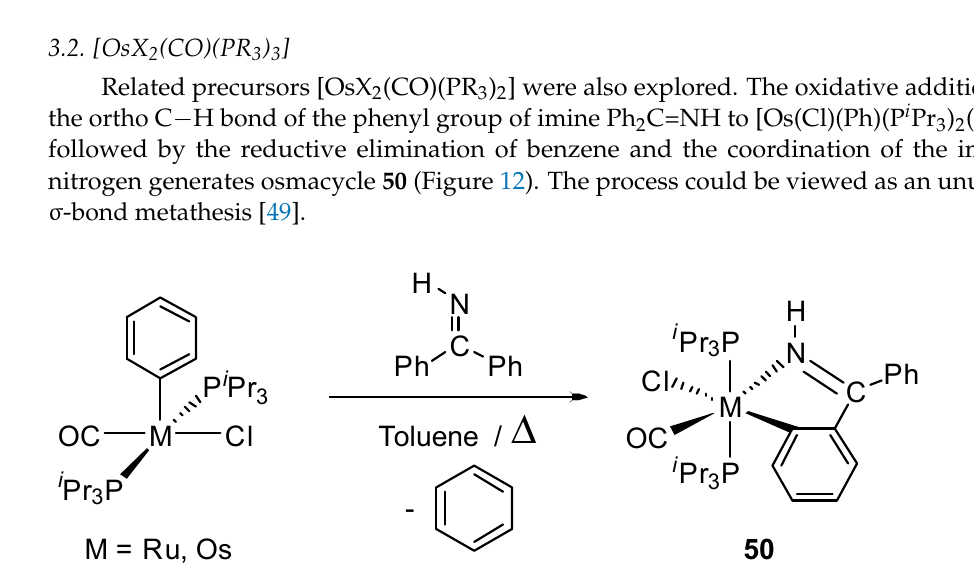
Figure 11. Unusual osmacycles prepared by activation of alkynes.